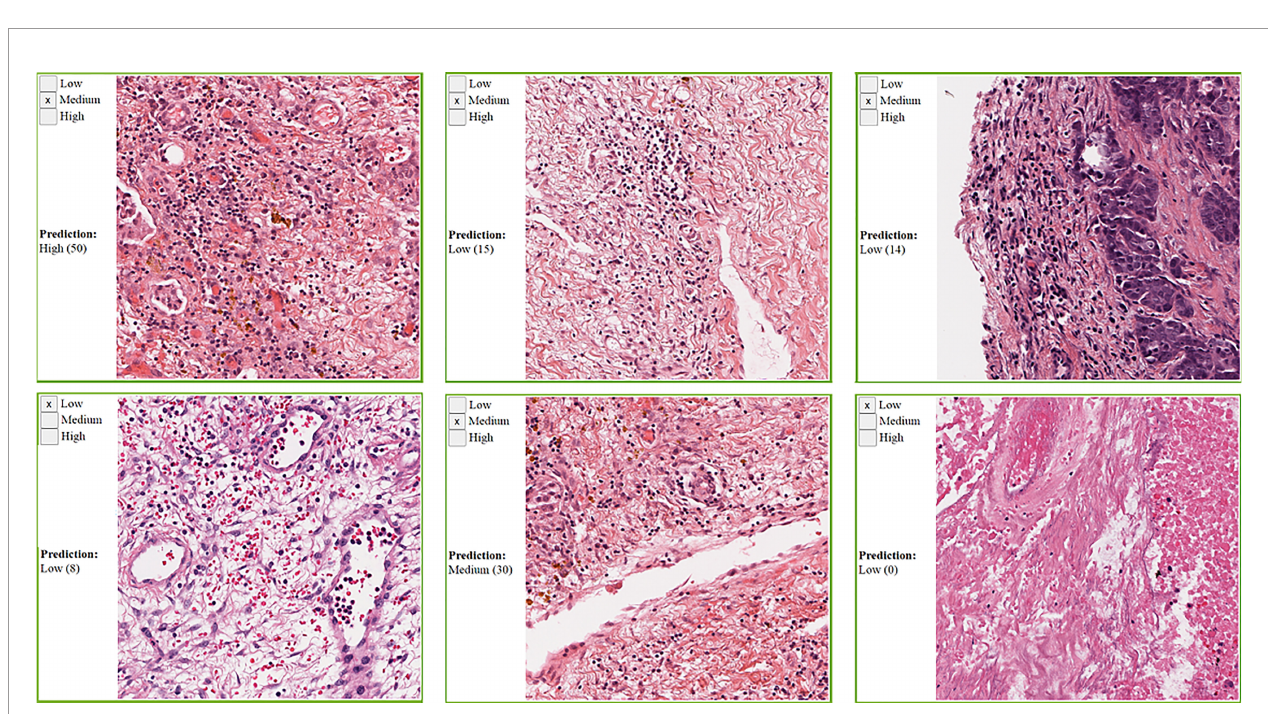
FIGURE 8 | Sample OV super-patches, showing the categorical label and the Inception model prediction. The model prediction is displayed as a category and a score between brackets. The models ’ scoring is a value in the range 0 to 64. We roughly interpret it as: Low if 0 ≤ core ≤ 21, Medium if 22 ≤ core ≤ 42, and High otherwise. Top row: cases where the category approximated from the model scoring does not match the pathologists ’ label. Bottom row: cases where the category approximated from the model scoring matches the pathologists ’ label.